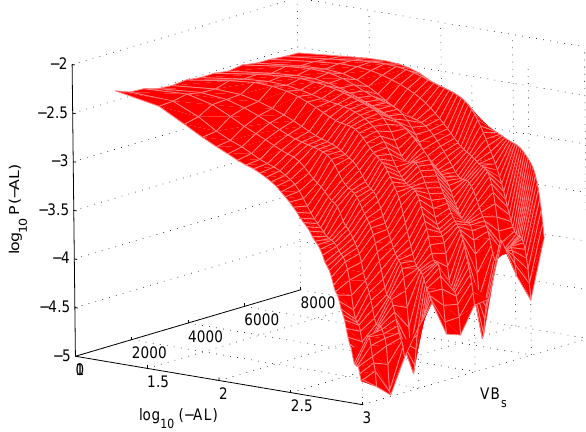
Fig. 48. Magnetospheric activity during substorms. The probability distribution function of AL index for different levels of solar wind induced electric field V B z . The shape of the probability distribution function depends on the solar wind V B z , and the deviation from the power law is stronger for stronger driving by the solar wind. The magnetospheric response does not exhibit scale-free response. (From Sharma et al.,